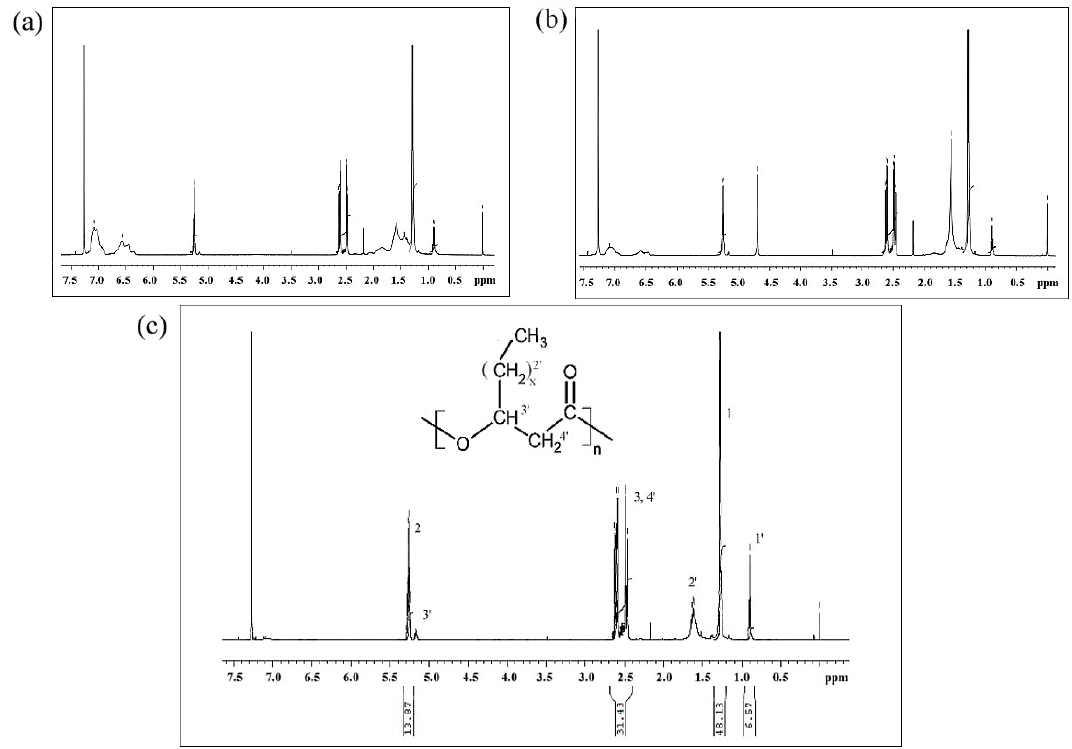
Figure 9. 1 H-NMR of PHAs produced from ( a ) PS0; ( b ) PS1; and ( c ) PS2 as an additional carbon source in TSB media.